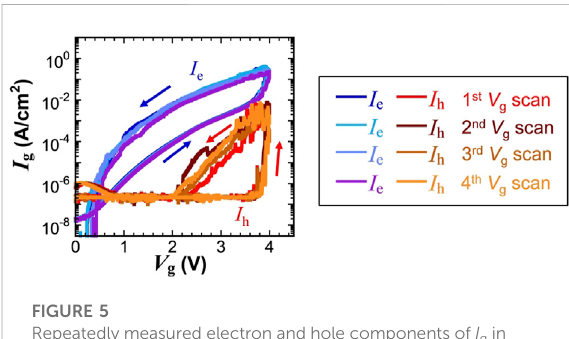
Repeatedly measured electron and hole components of I g in the FeFET. Repeatable current implies that it is not a behavior of permanent trap generation.